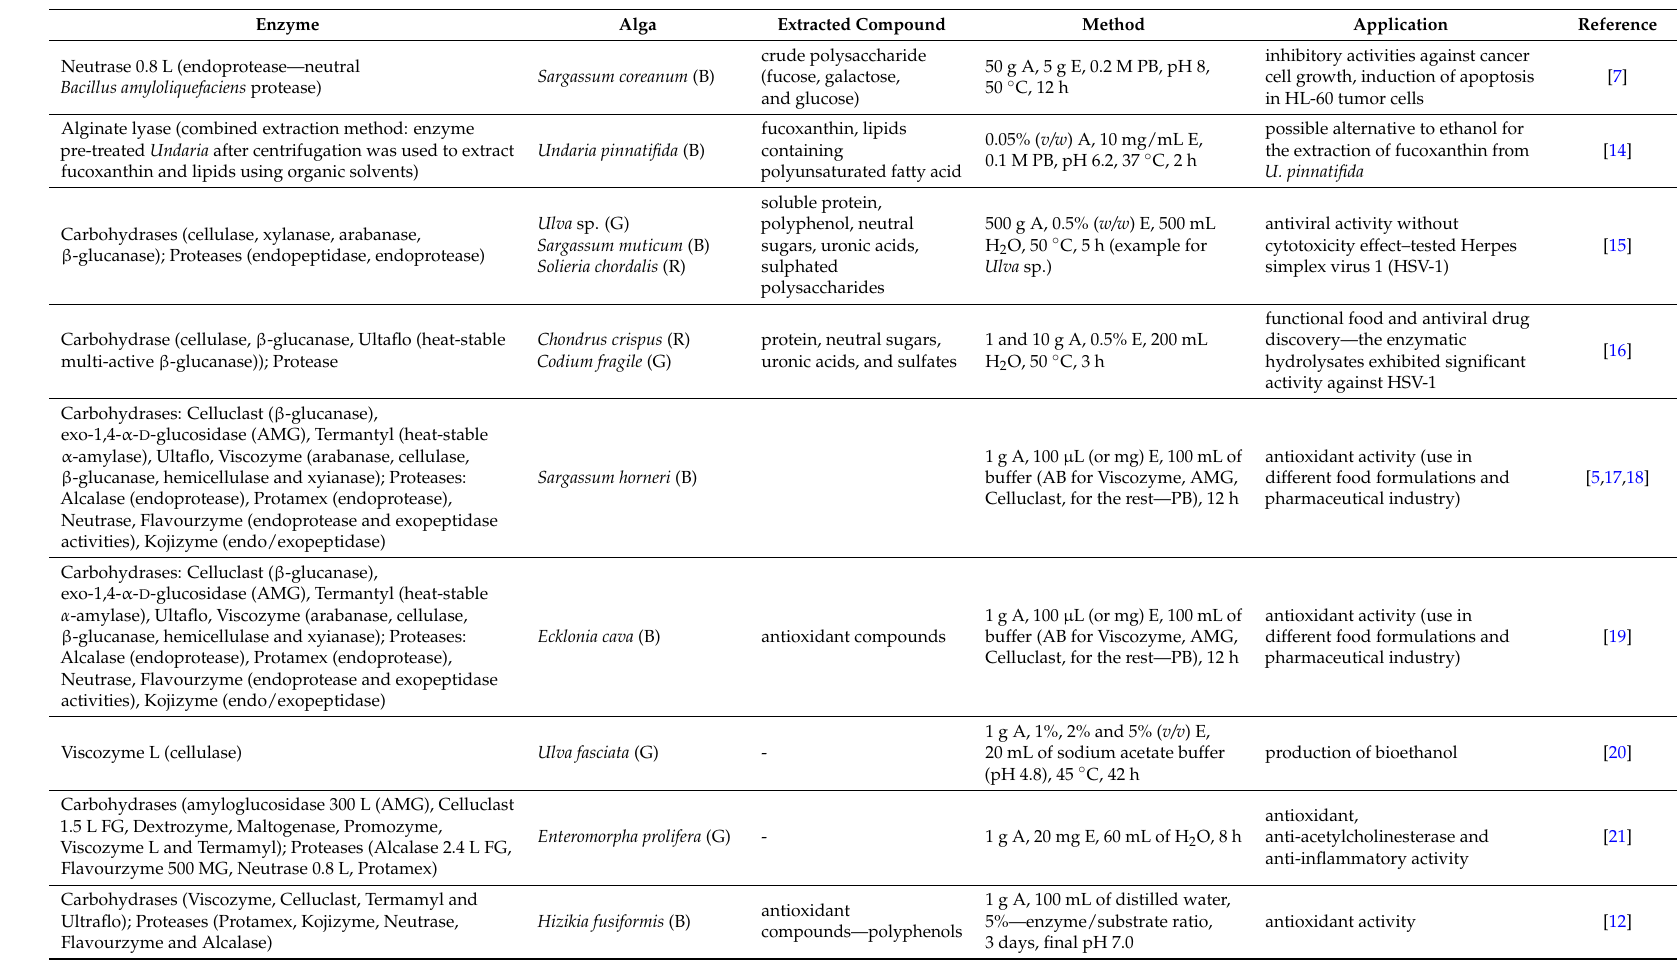
Table 1. Examples of the enzyme-assisted extraction of biologically active compounds from the biomass of macroalgae and their applications. Enzyme Alga Extracted Compound Method Application